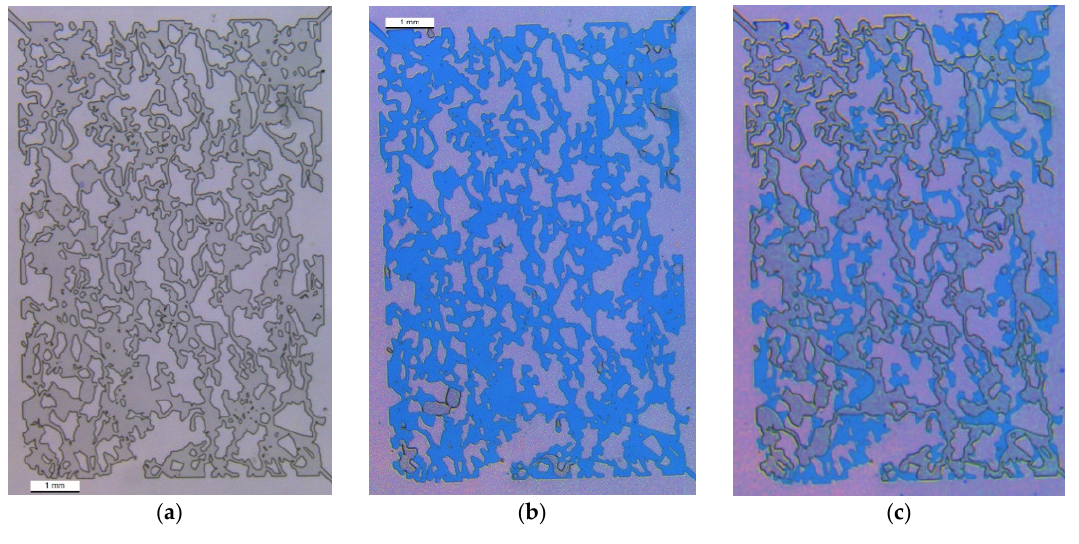
Figure 6. Gas flooding liquid phase retention in 50 μ m model. ( a ) Dry microfluidic chip model; ( b ) Saturated liquid model; ( c ) After 500 mbar constant gas pressure displacement.